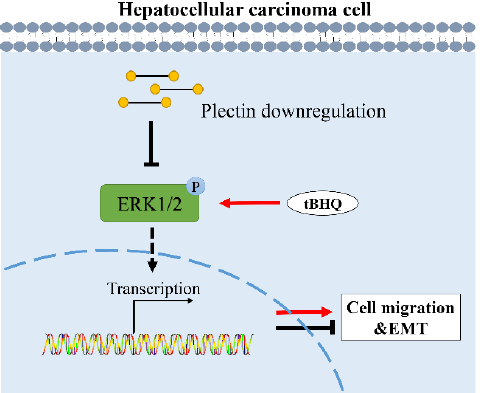
Figure 5. Proposed schematic diagram of the regulation of HCC cell migration and EMT by plectin downregulation. Downregulation of plectin decreases the expression of p-ERK1/2, then inhibits the EMT process and migration ability of HCC cells. tBHQ treatment recovers p-ERK1/2 protein expression and recovers the EMT process and migration ability of HCC cells caused by plectin downregulation. This confirms that downregulation of plectin inhibits HCC cell migration and EMT through ERK1/2 signaling. EMT: epithelial mesenchymal transformation; p-ERK1/2: phosphoryla- tion of extracellular regulated protein kinases 1/2; tBHQ: